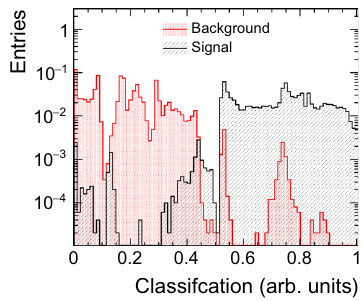
Fig. 4 SOM classification distribution for signal and